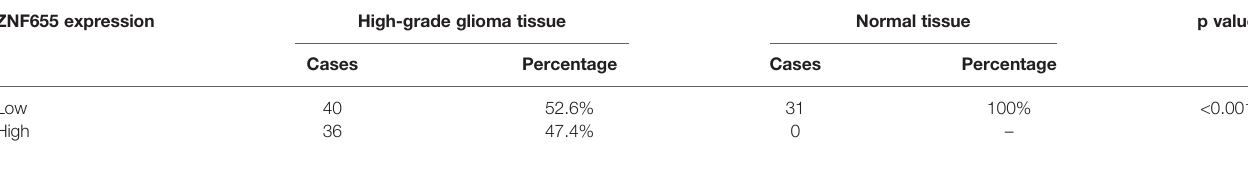
TABLE 1 | Expression patterns in glioma tissues and normal tissues revealed in immunohistochemistry analysis.